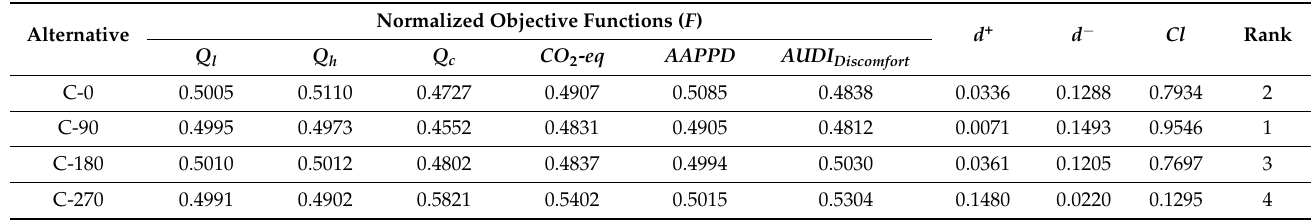
Table 6. The TOPSIS results for different orientations of the building type